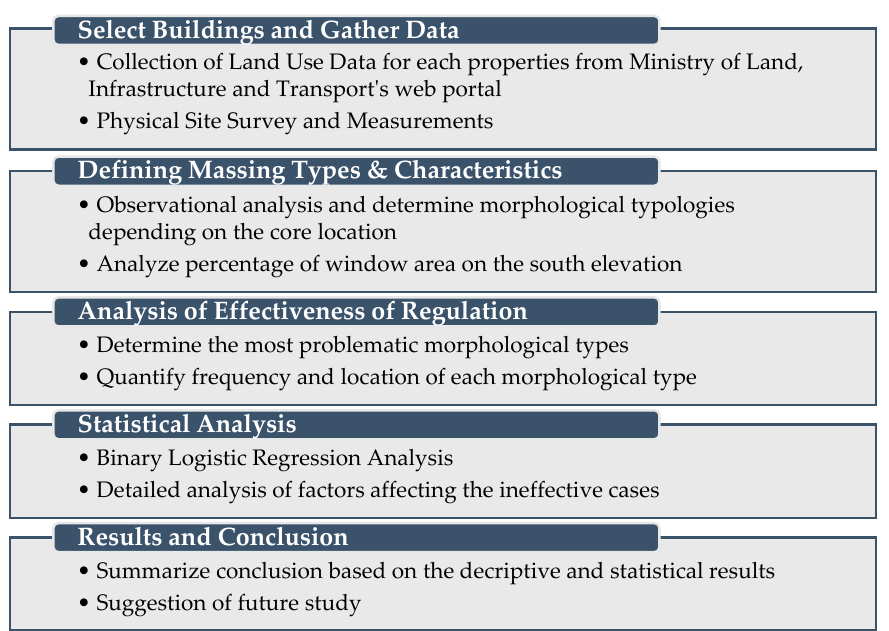
Figure 6. Framework of the research methods and process.